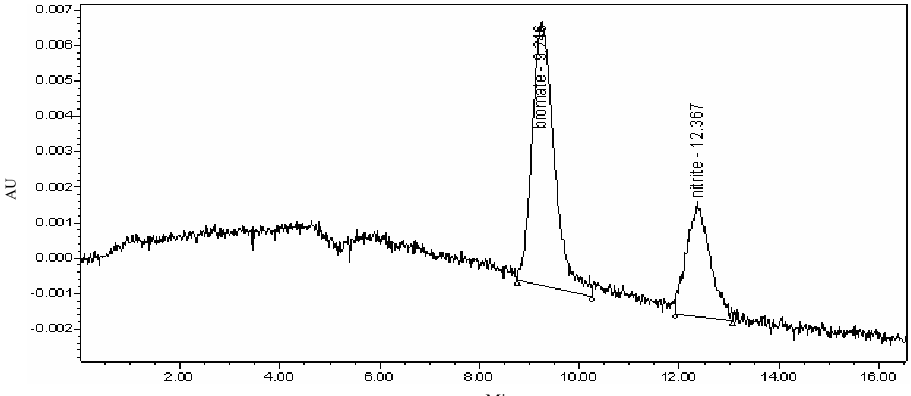
Figure 5. Analysis of mixture of 100 µg/L bromate standard and 100 µg/L nitrite solution with HPLC system, chromatographic conditions are listed under experimental conditions, wavelength 400 nm